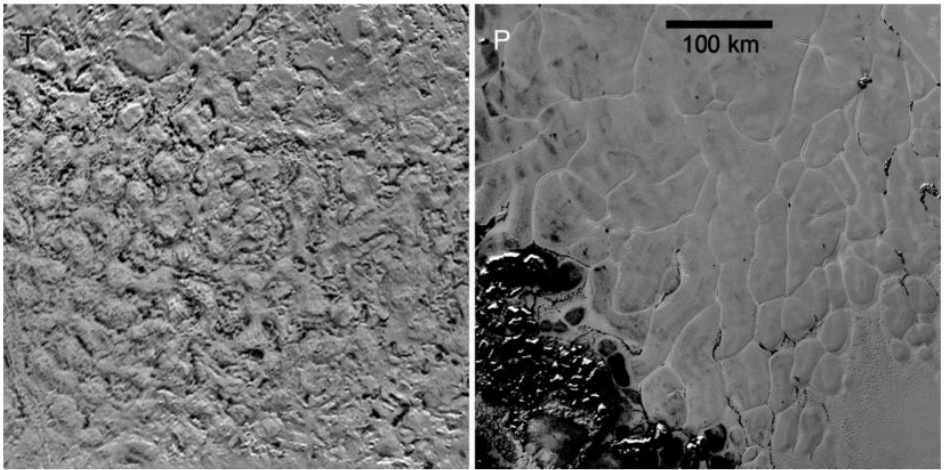
Figure 31. Cellular plains on (T) Triton and (P) Pluto. Images shown at same effective scale (0.35 km/pixel); scene width is ~450